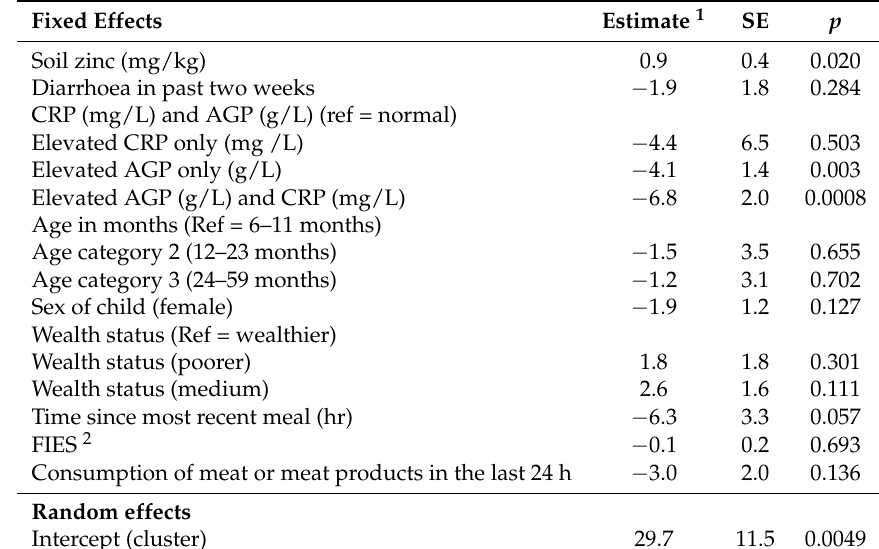
Table 4. Multi-level mixed linear regression model predicting serum zinc ( n =